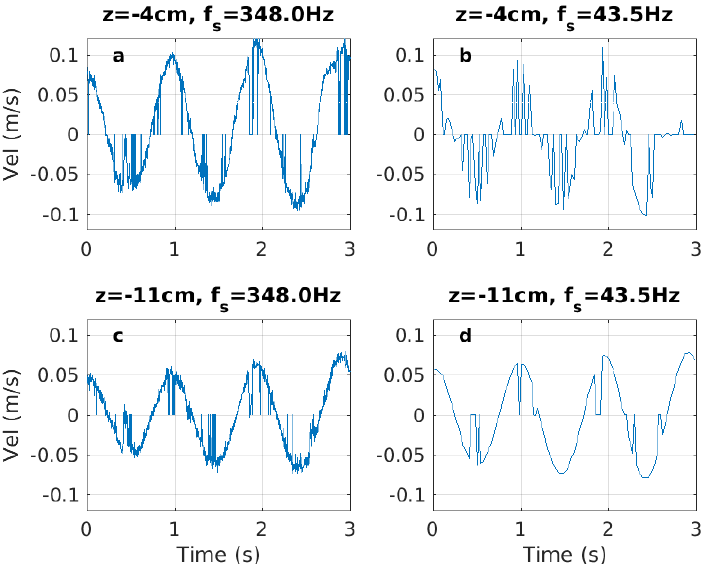
Figure 10. Along-tank velocity time series from trial 18, determined from PIV data using two different sampling rates at two different depths near the center of each image (X ≈ 2 cm). Left panels ( a , c ) use a sample rate of 348 Hz. Right panels ( b , d ) use a sample rate of 43.5 Hz. Top panels ( a , b ) show velocities at 4 cm below mean water level (MWL). Bottom panels ( c , d ) show velocities at 11 cm below MWL. (NB: for times when data are rejected, the time series are set to zero.)